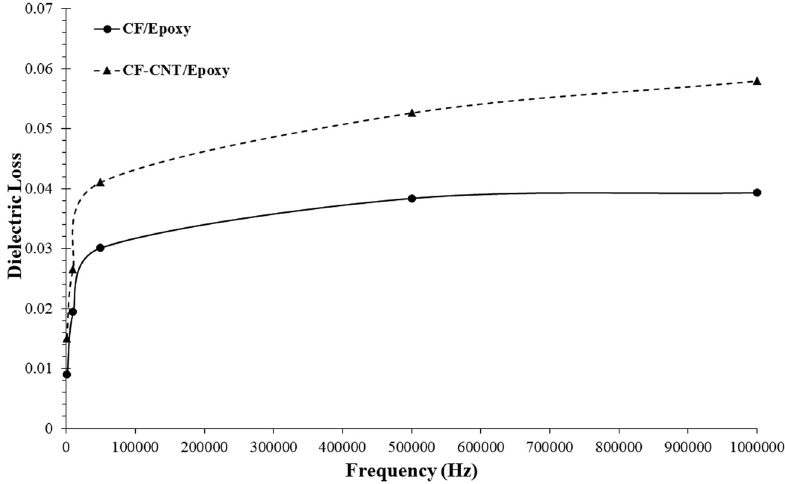
Figure 12: Frequency dependence of the dielectric loss of CF/epoxy and CF – CNT/epoxy.